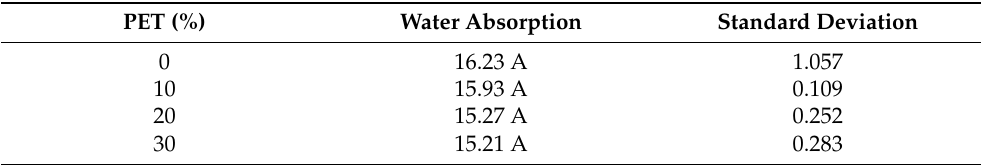
Table 5. Water absorption of samples at 28 days. PET (%) Water Absorption Standard